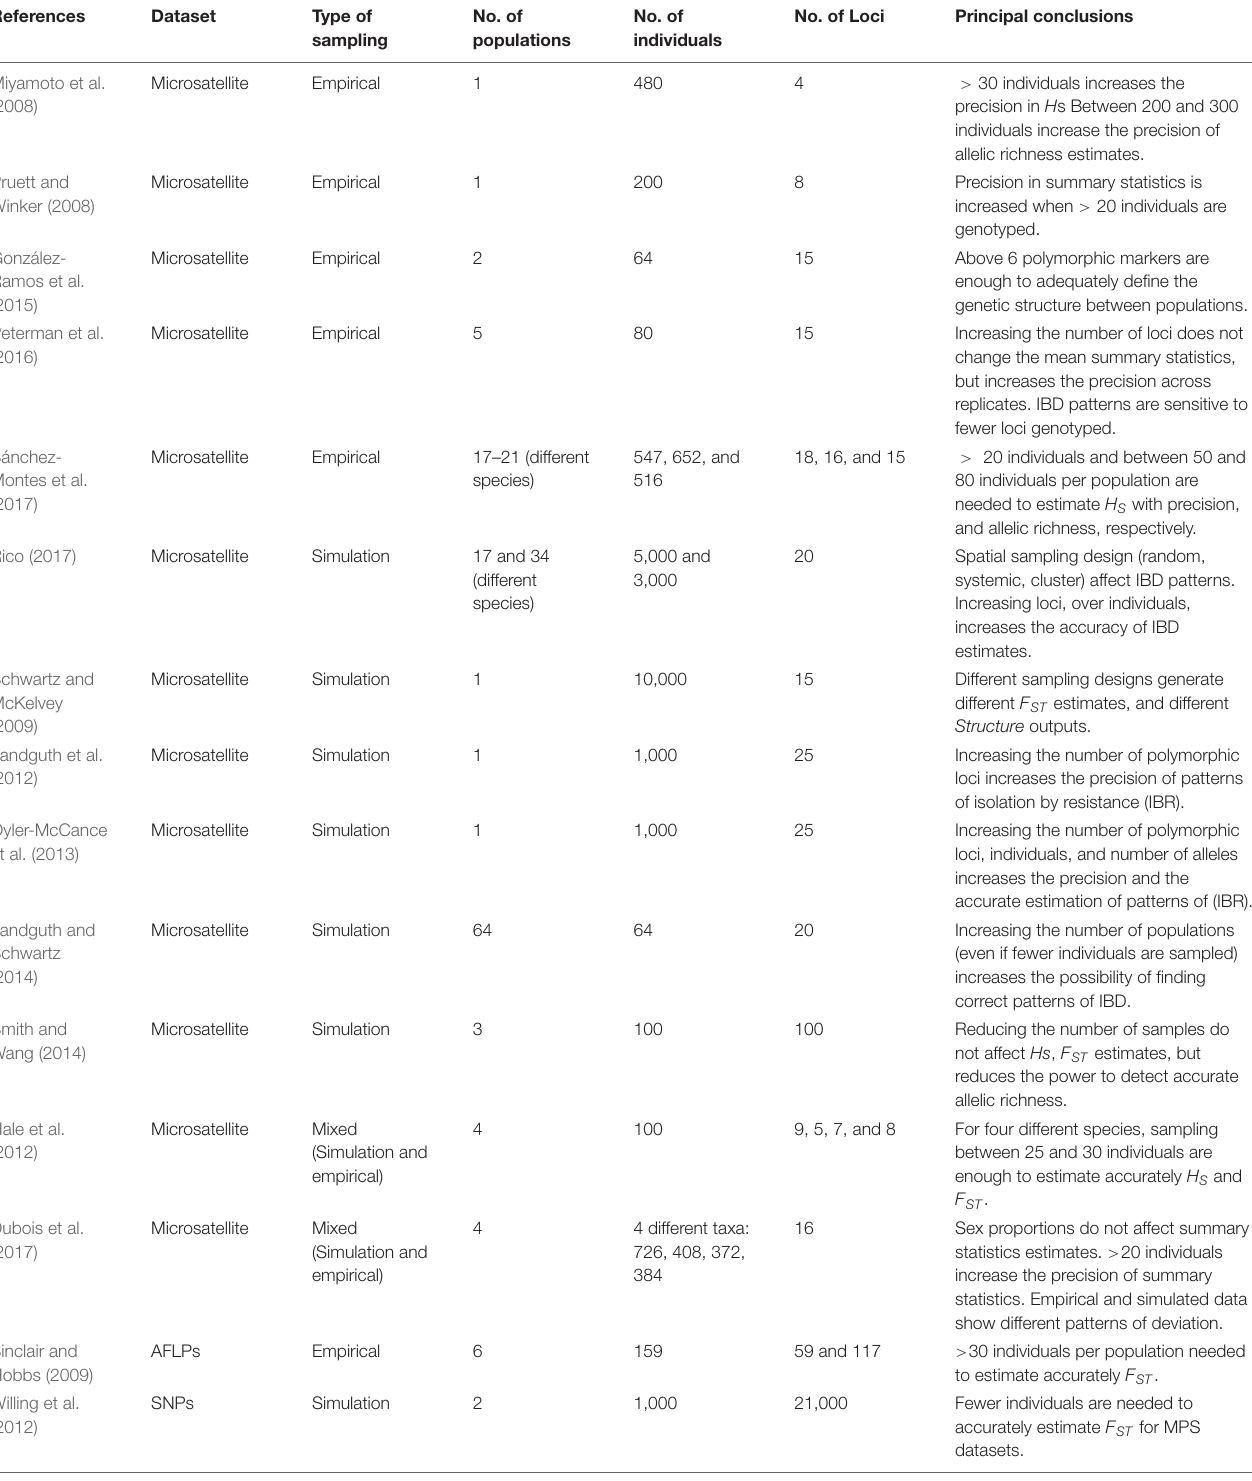
TABLE 1 | Summary of 19 studies that have evaluated sampling designs using different markers (Microsatellites, AFLPs, SNPs); empirical vs. simulated data; and varying the number of loci, individuals, and